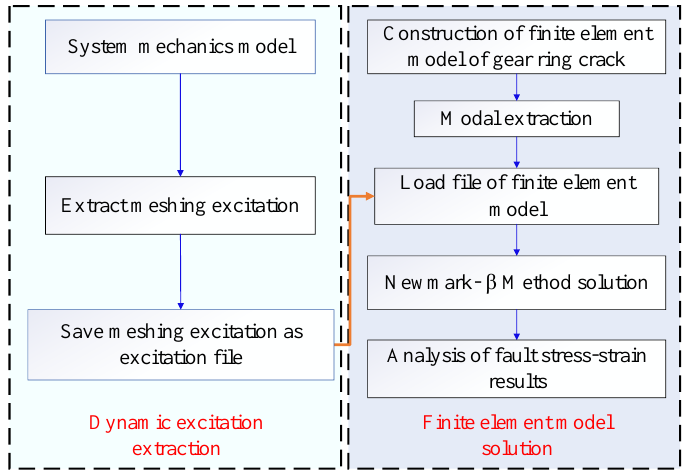
Figure 17. Flow chart of dynamic strain solution for inner ring root crack fault.